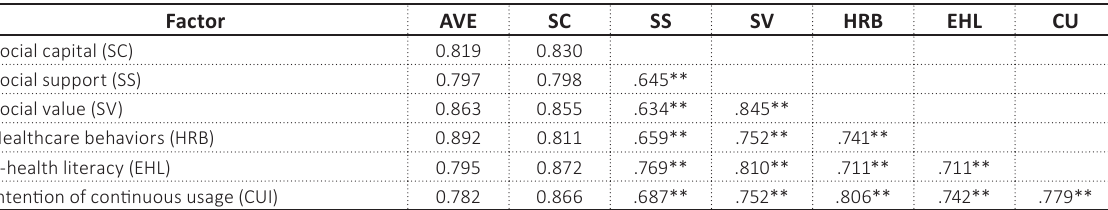
Table 3. Correlation matrix and AVE